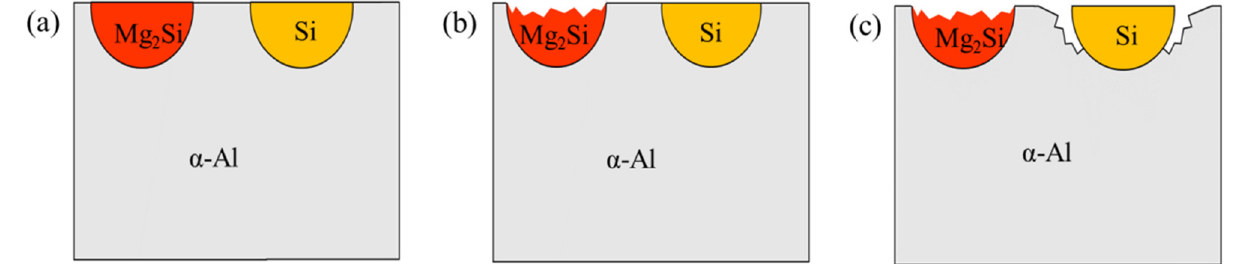
Figure 11: Schematic diagram of micro - galvanic corrosion process in Al – Mg – Si series aluminum alloys: ( a ) before corrosion, ( b ) Al – Mg 2 Si galvanic corrosion, and ( c ) Al – Si galvanic